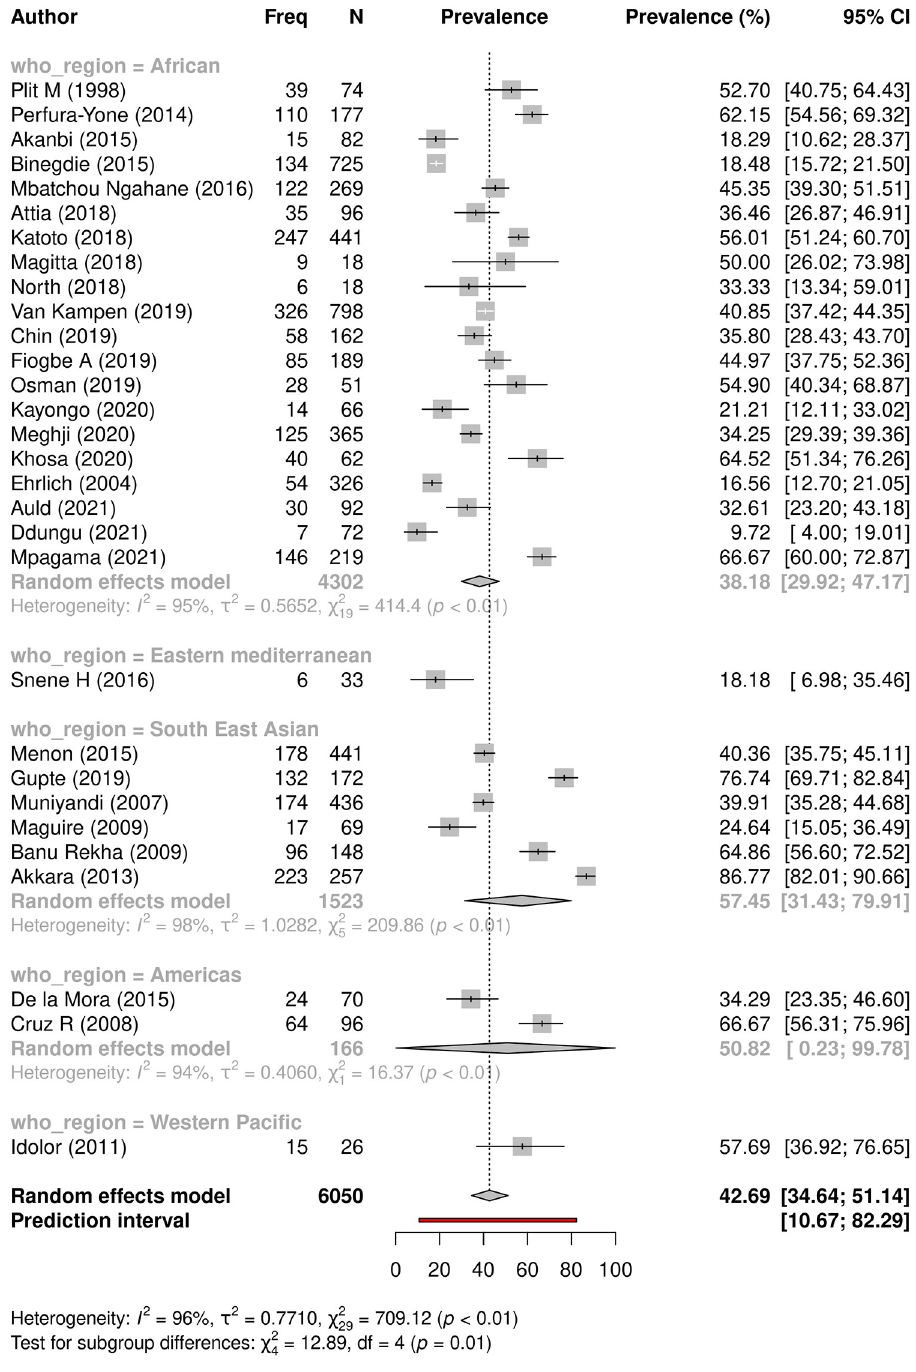
Fig 7. Prevalence of PTLD across World Health Organisation regions. A forest plot showing subgroup meta- analysis comparing prevalence of PTLD as a composite outcome (abnormal spirometry or persistent symptoms or abnormal radiology) in all 30 studies across five WHO